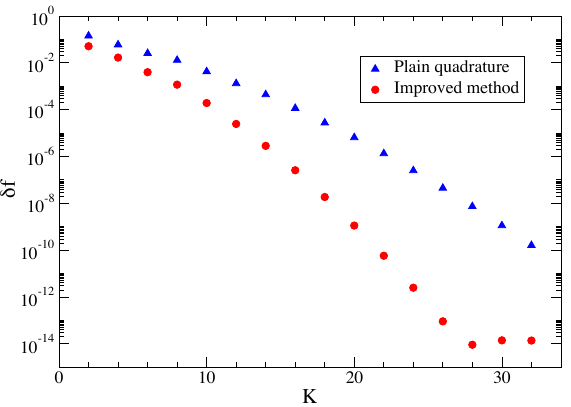
Figure 1 . Relative error of free energy as a function of K with D = 32 on a 1024 (cid:2) 1024 lattice. K is the polynomial order of the Gauss-Legendre quadrature in eq.